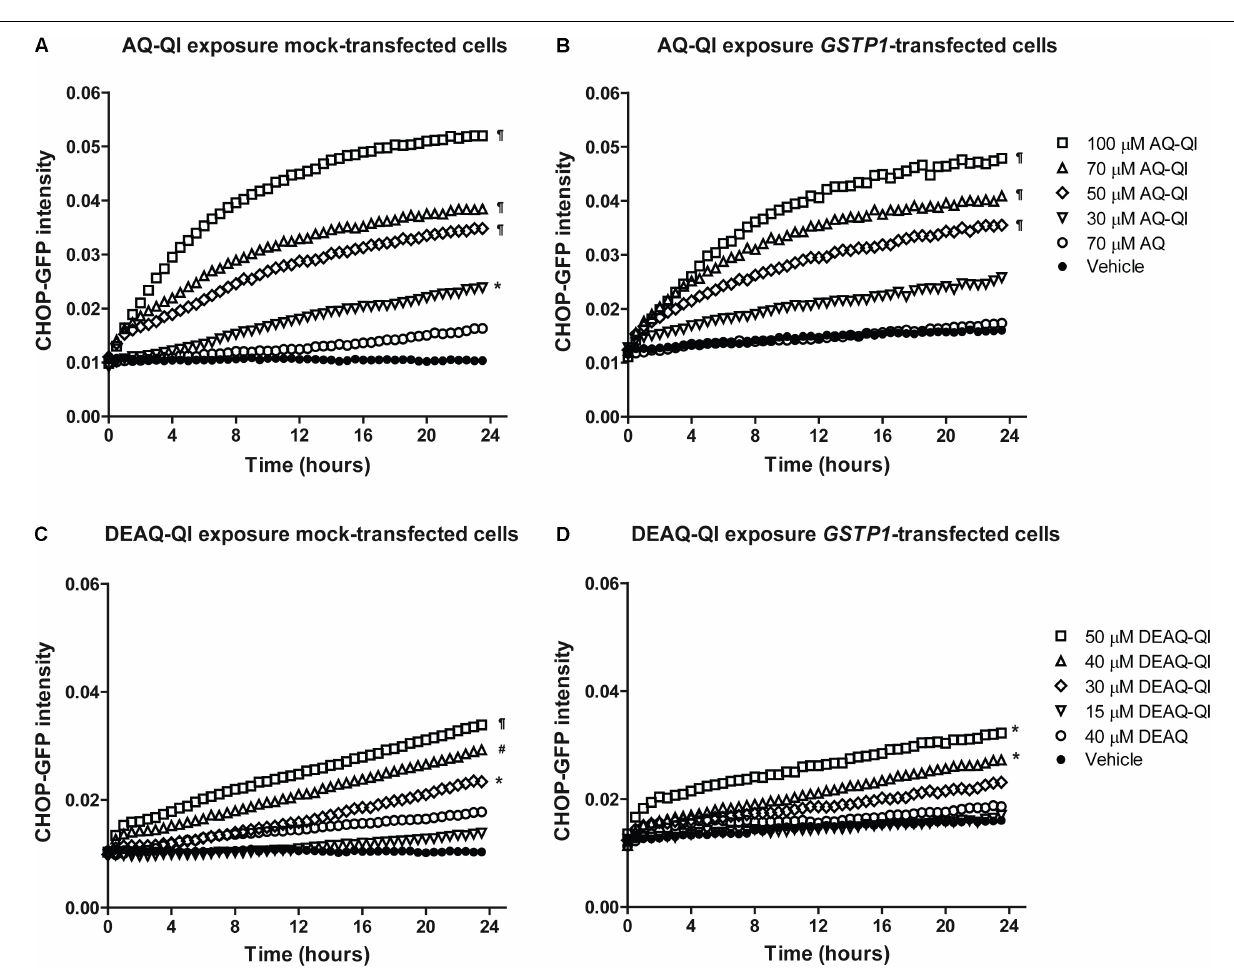
FIGURE 7 | Time dynamics of CHOP-GFP reporter activation following exposure to AQ-QI (A,B) or DEAQ-QI (C,D) . Prior to exposure, HepG2 DDIT3/CHOP-GFP cells were transfected with empty vector (A,C) or GSTP1 cDNA (B,D) . Statistical significant differences with corresponding vehicle control from each group are denoted with ∗ p < 0.05, # p < 0.01, and ¶ p < 0.001; analyzed by linear mixed effect model as described in detail in section “Materials and